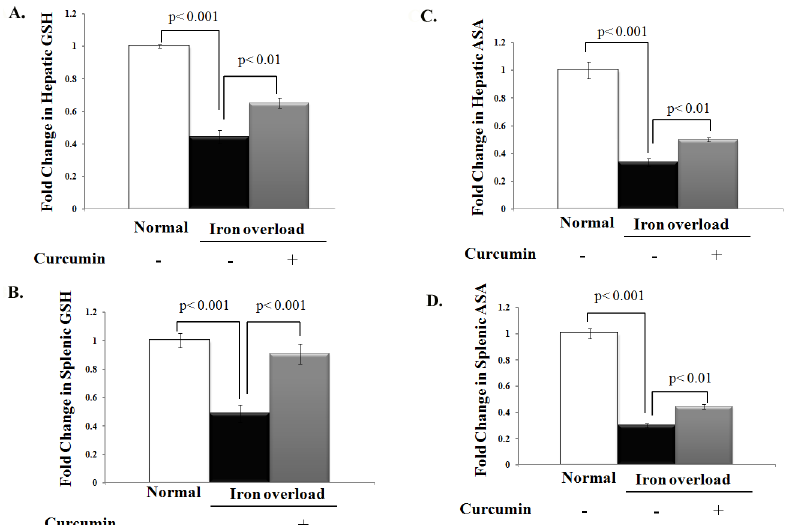
Fig 3. Curcumin improves levels of endogenous non-enzymatic antioxidants that were depleted by chronic iron intake. A, B) Fold change in the level of reduced glutathione (GSH, mg/g wet tissue) in liver and spleen, respectively, relative to that of normal control. C, D) Fold change in the level of ascorbic acid (ASA, mg/g wet tissue) in liver and spleen, respectively, relative to that of control. Levels of GSH and ASA in liver and spleen were decreased in iron-overloaded rats and curcumin treatment significantly improved the decrease in GSH and ASA levels in iron overloaded rats. Data shown are the mean ± SD (n = 5).